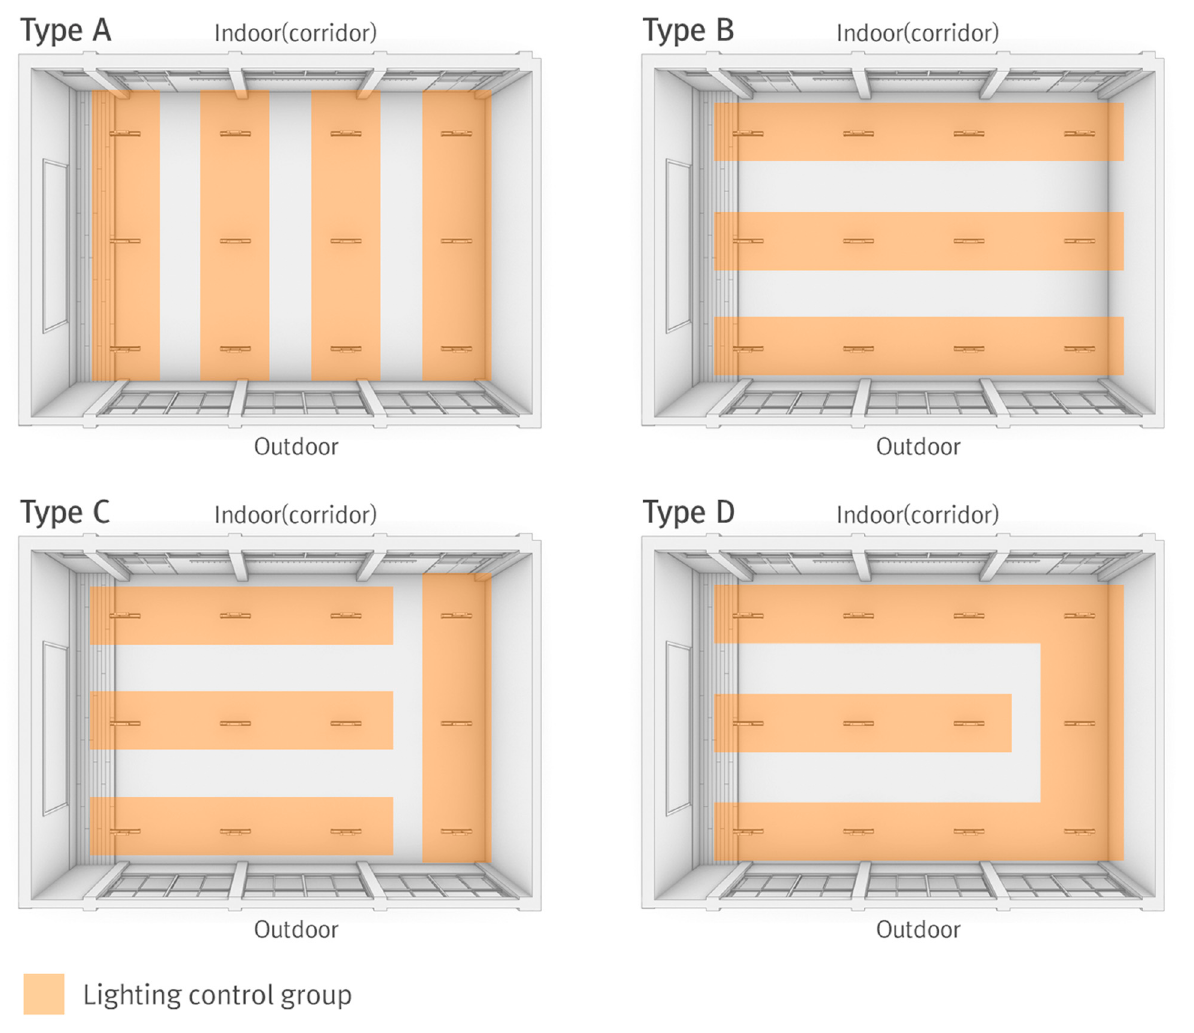
Figure 5. Types of lighting control groups.